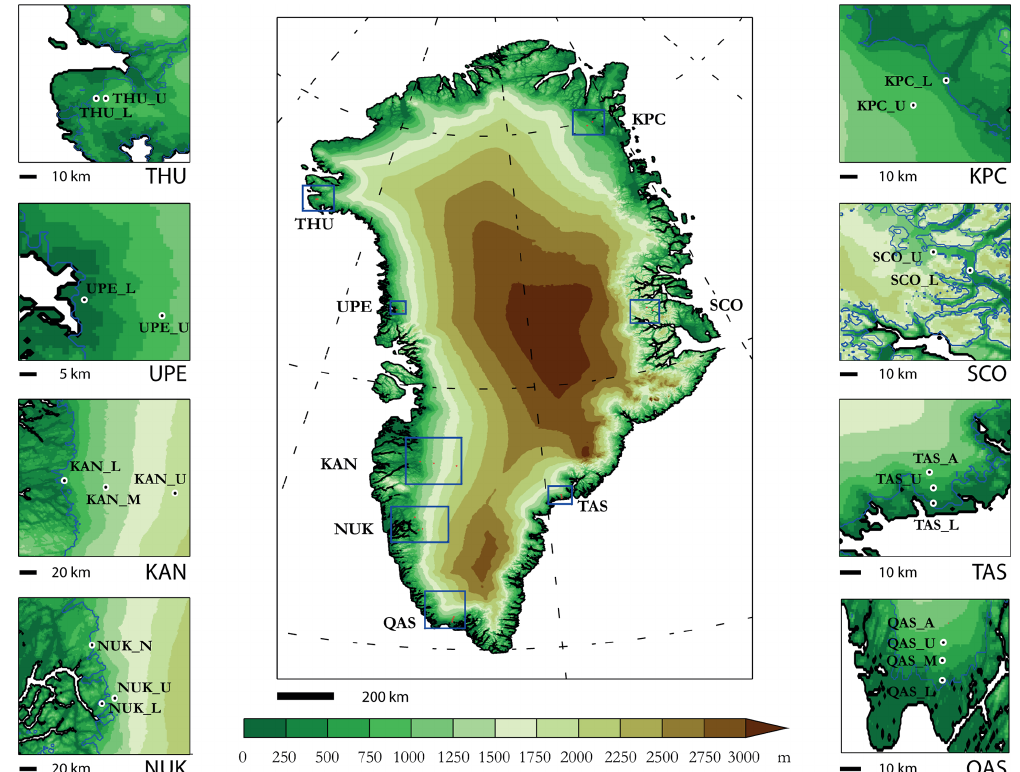
Figure 1. Localization of the 21 AWSs from the PROMICE network used in the study. The blue lines in detailed maps represent the ice sheet